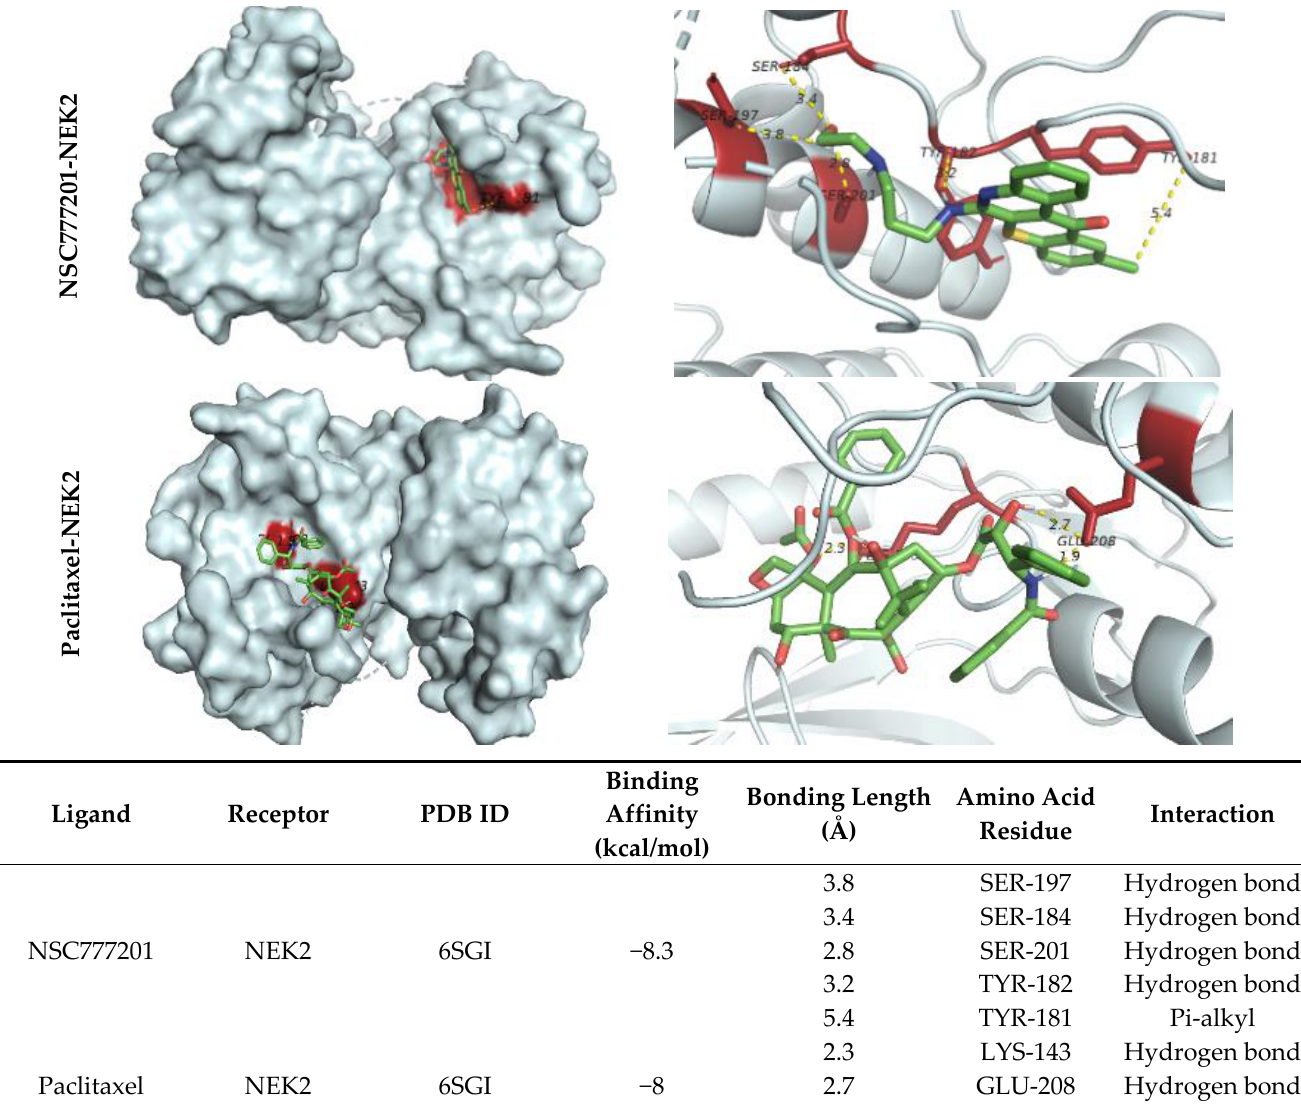
Table represents the ligand-receptor interacting atoms, binding affinities, and interacting distances of NSC777201 and TTK. Figure 7. Docking profile of TTK with NSC777201 and paclitaxel (a known inhibitor). 3D structure of ligand-receptor interactions shown in the left panel. The right panel shows the 2D representation of the interaction with ligands and the receptors in the binding pocket.